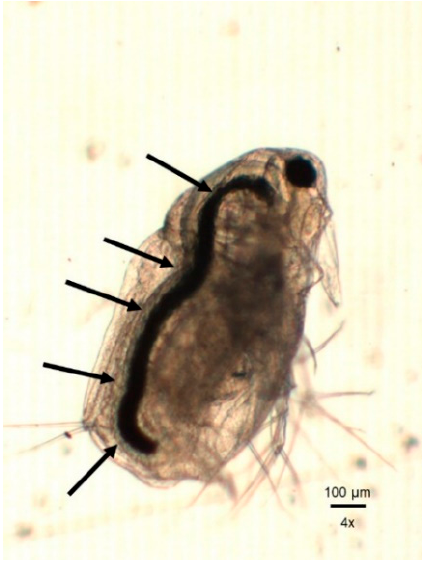
Figure 4. Photograph of dead Daphnia magna . Digestive tract filled with BC particles as indicated by the arrows.